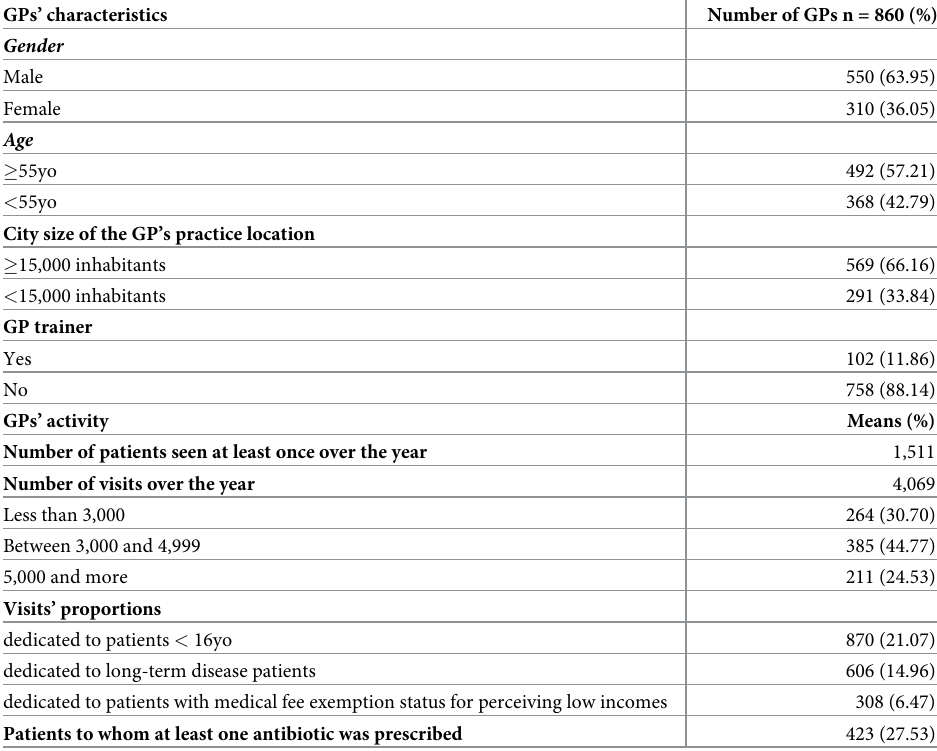
Table 1. Descriptive statistics of the